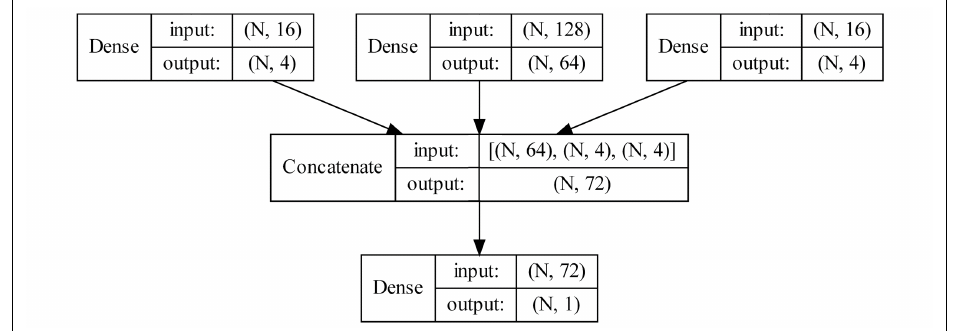
Figure 9. Structure of the top layers of the multi-modal neural network. There are three inputs, satellite images (left), tabular features (middle), and property images